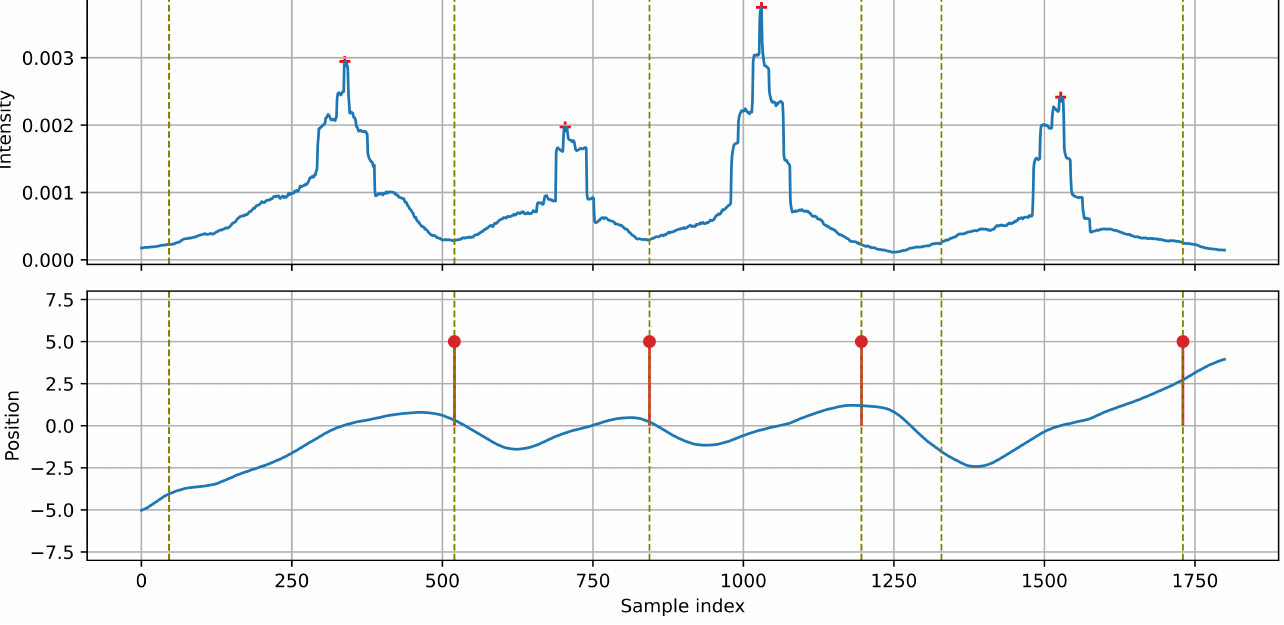
Figure 8. Example of detection: four vehicles moving close to each other, left to